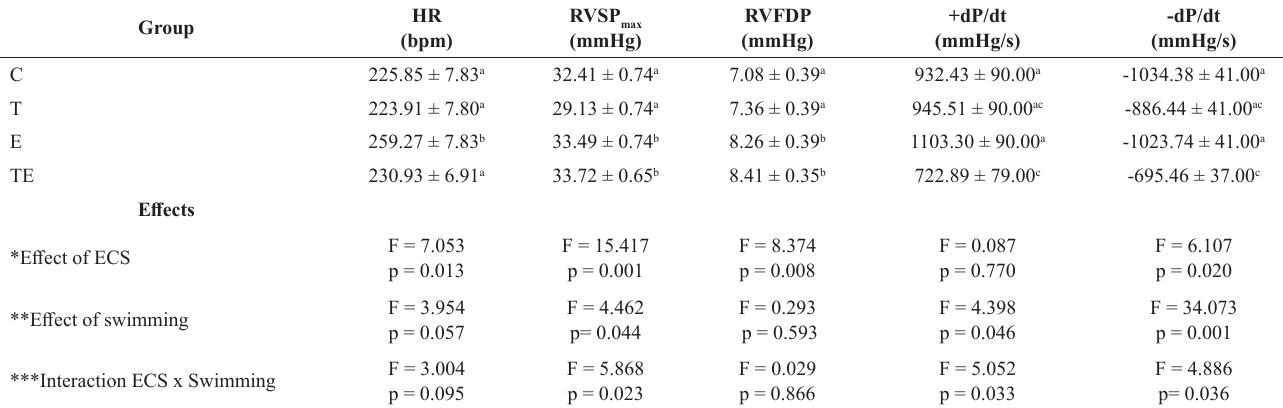
Table 2 - Hemodynamic